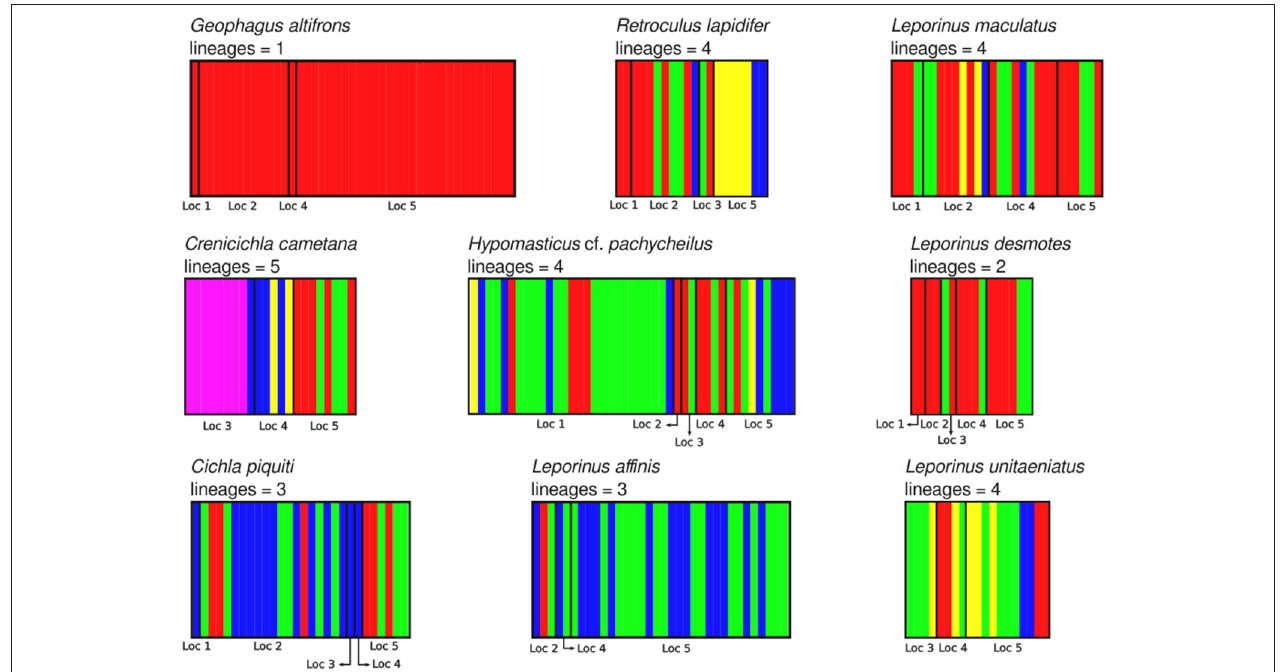
FIGURE 5 | Identification of lineages of all nine species analyzed in this study using BAPS v6.0. Localities are: (1) Zé dos Gatos rapid; (2) São Miguel rapid; (3) Remanso dos Botos rapid; (4) Santa Isabel rapid; (5) São Bento rapid and Rebojo rapid.